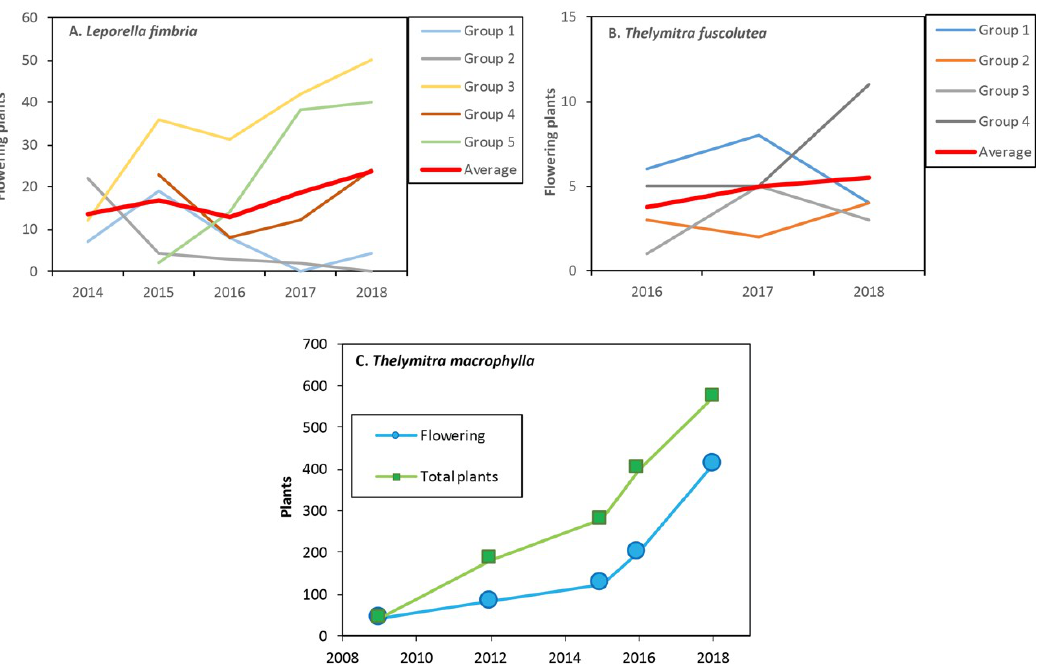
Figure 3. Population size trends for populations of orchid species showing annual differences in numbers of ( A ) Leporella fimbria , ( B ) Thelymitra fuscolutea and ( C ) Thelymitra macrophylla .